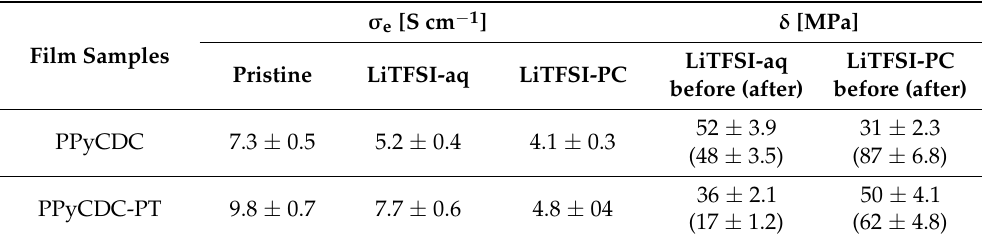
Figure 1. ( a ) Galvanostatic electropolymerization (0.1 mA cm − 2 , 11.1 h, − 20 ◦ C, EG:Milli-Q+ 50:50 wt.%) in a two-electrode cell forming PPyCDC (black curve) and ppyCDC-PT (red curve). The SEM images of the surface (scale bar 20 μ m), with the inset of cross-section image (scale bar 10 μ m), showing ( b ) PPyCDC and ( c ) PPyCDC-PT films. Table 1. Electric conductivities σ e and elastic modulus δ of PPyCDC and PPyCDC-PT films before and after actuation in the LiTFSI aq and PC electrolytes.